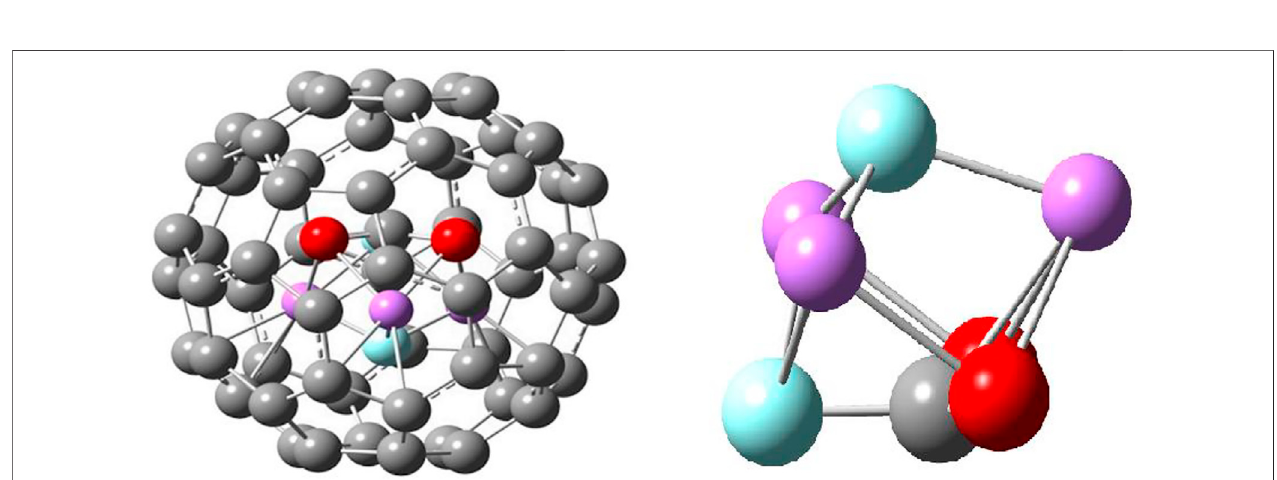
FIGURE 9 | Equilibrium structures of [Li 3 F 2 -CO 2 ]@C 60 endofullerene and Li 3 F 2 -CO 2 inside C 60 from Ref. 44.